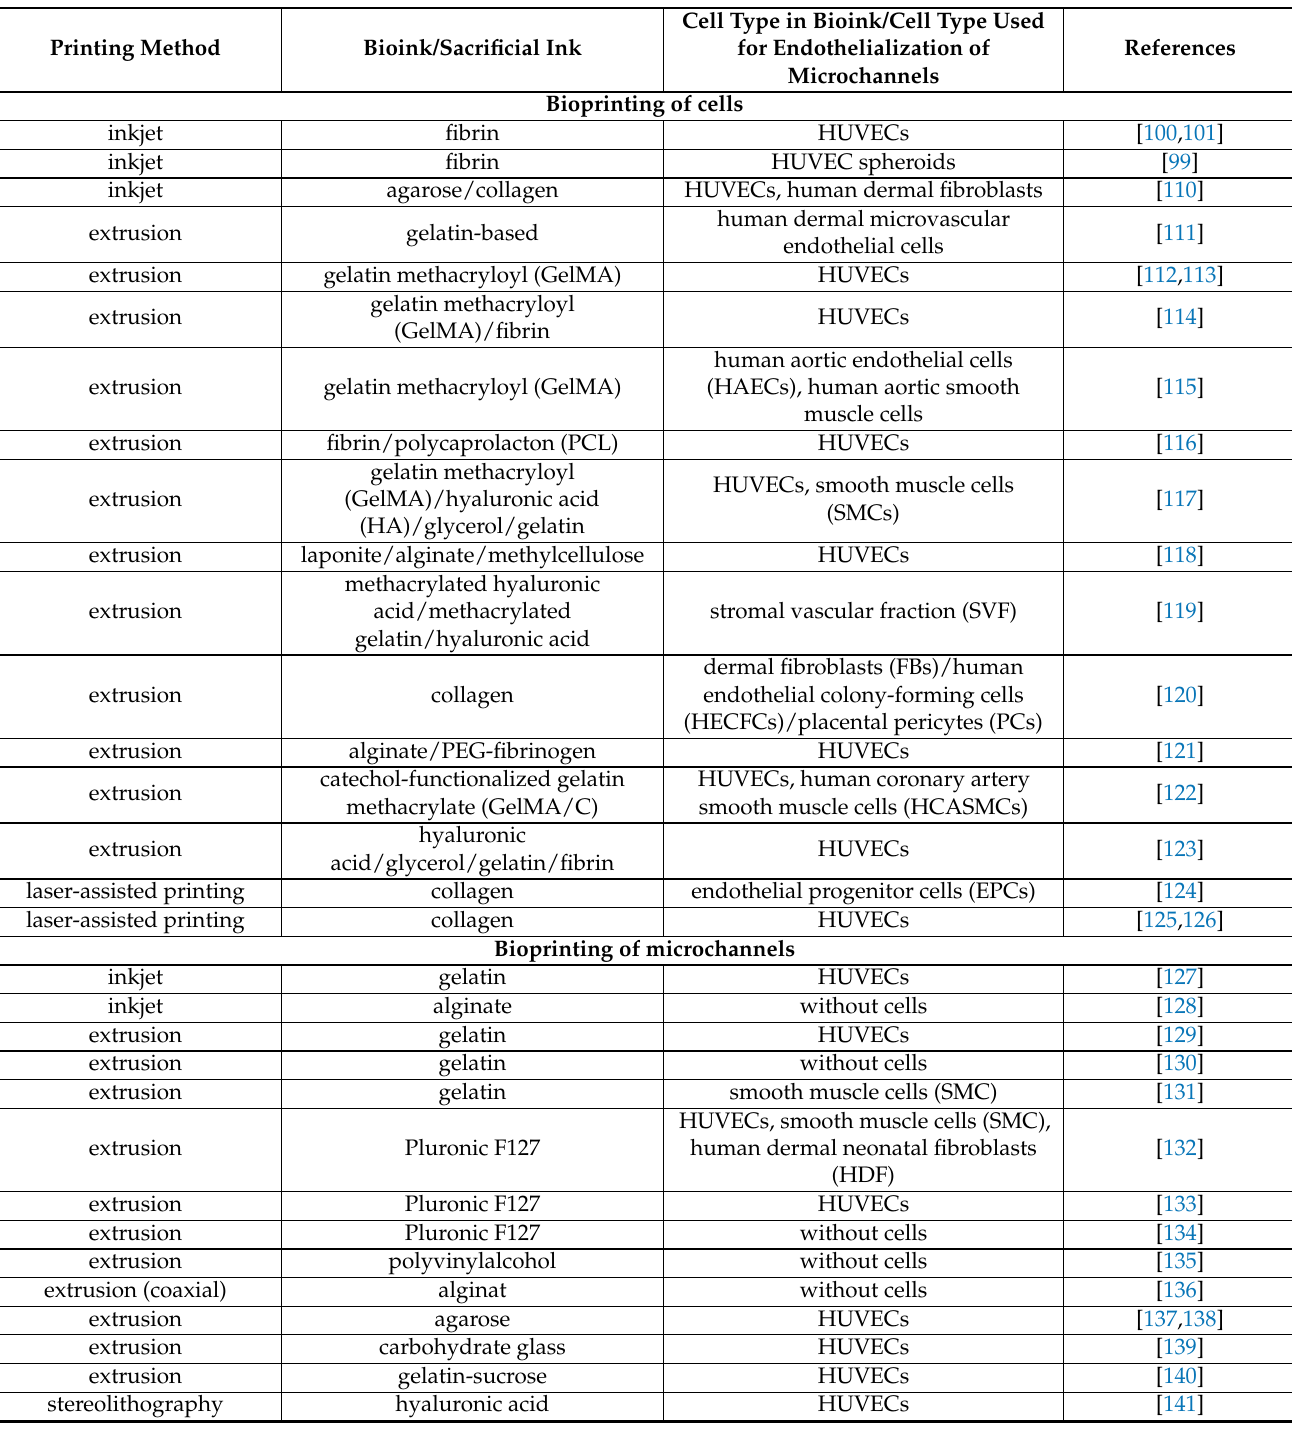
Table 2. Strategies for the bioprinting of blood vessels: bioprinting of cells and bioprinting of